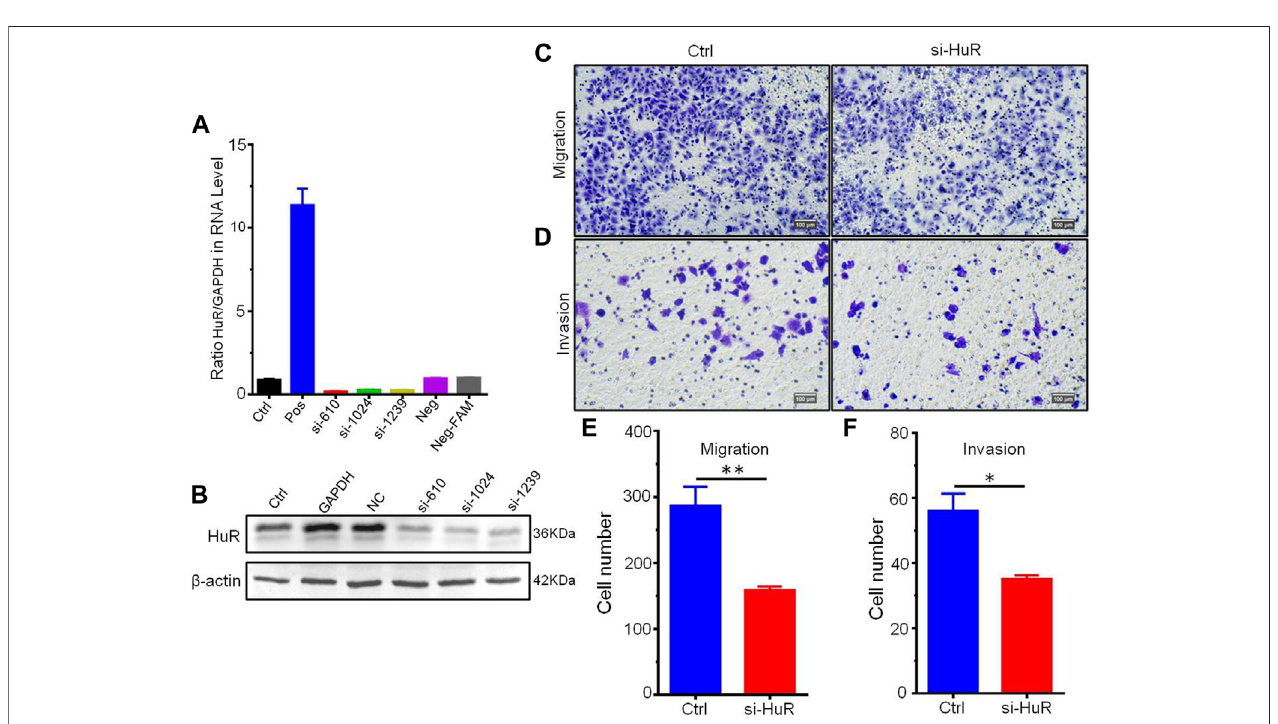
FIGURE5| HuRpromotesthemigrationand invasionofA549cells.MigrationassayofA549HuRKDcells(1*10 5 /well)compared withA549cellsasacontrol.The expression of HuR genes was detected by western blotting and real-time PCR to verify the interference effect of siHuRs in A549 cells (A,B) . Cells that migrated into the lowerchamber werephotographed (C) andquanti fi ed (E) .MatrigelcellinvasionassayofA549HuRKDcells(1*10 5 /well)comparedwithA549cellsasacontrolfor24 h. CellsthatinvadedthroughtheMatrigelwerephotographed (D) andquanti fi ed (F) .Scalebar100 μ m* p < 0.05,** p < 0.01,*** p < 0.001.Dataarerepresentedasthe mean ± SEM. All experiments were repeated at least three